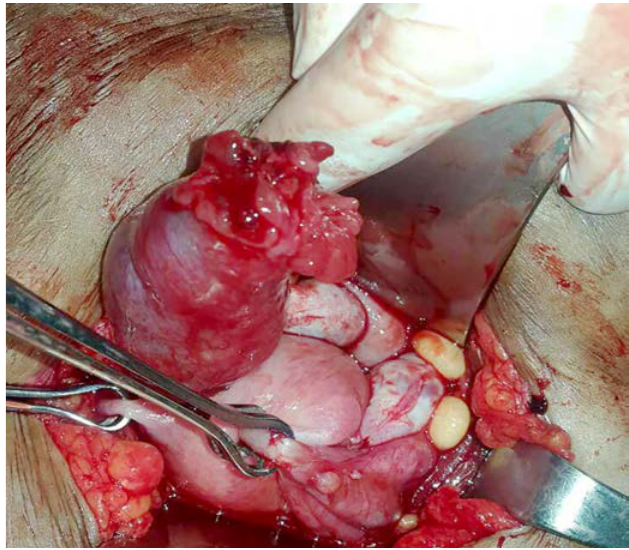
Fig 2 : Omental biopsy showing